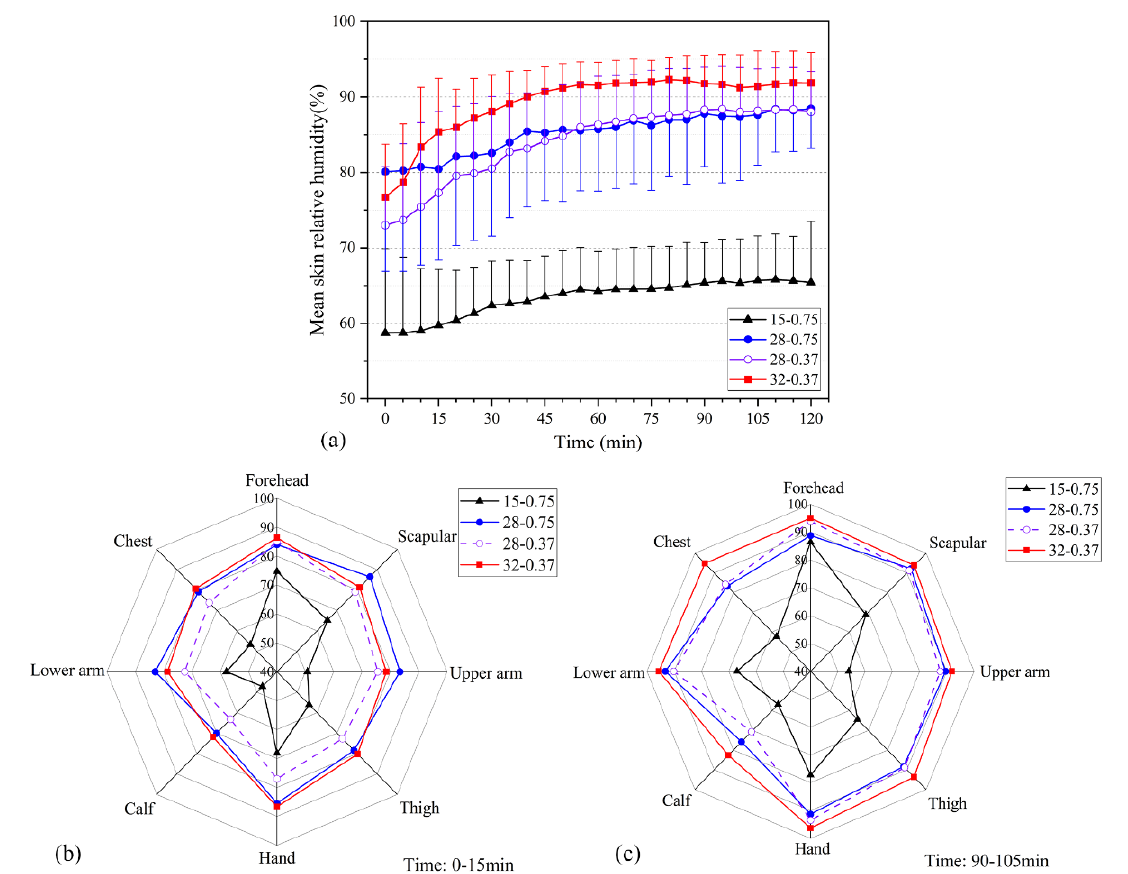
Figure 5. Skin relative humidity under the four testing scenarios (i.e., 15 ◦ C–0.75 clo, 28 ◦ C–0.75 clo, 28 ◦ C–0.37 clo, 32 ◦ C–0.37 clo; testing scenarios in the figures are presented as A–B, where A represents the WBGT value and B represents the insulation of the inner garments used in the testing). ( a ) Mean skin relative humidity. ( b ) Local mean skin relative humidity at 0–15 min; ( c ) Local mean skin relative humidity at 90–105 min.